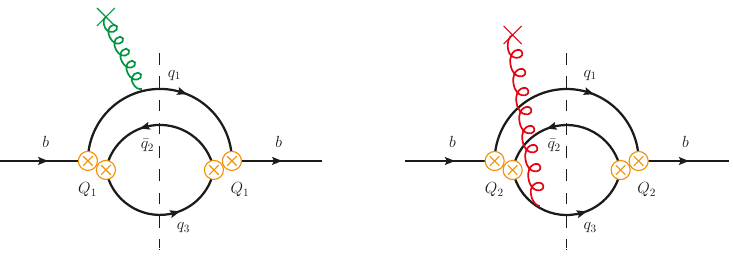
Figure 2 . The two-loop diagrams describing power corrections up to dimension-six from Q 1 ⊗ Q 1 (left) and Q 2 ⊗ Q 2 (right) contributions.